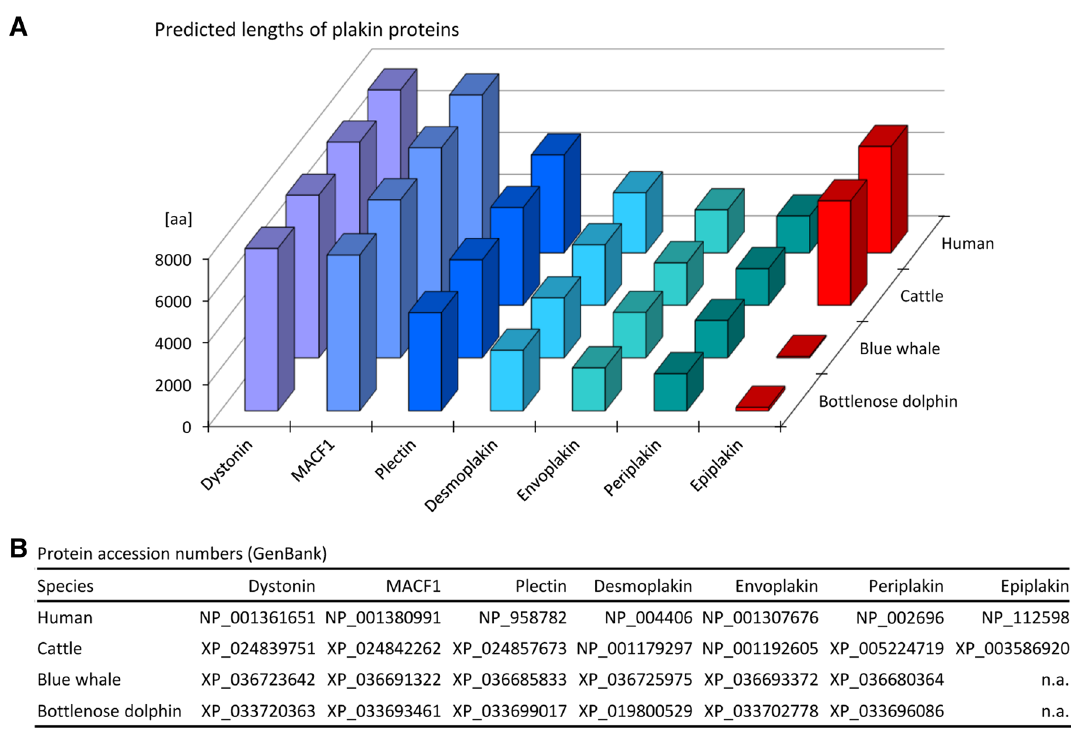
Figure 1. Size of plakin family proteins of land-dwelling mammals and cetaceans. ( A ) The predicted lengths of plakin family proteins are shown for human, cattle, blue whale and bottlenose dolphin. aa amino acid residues. ( B ) GenBank accession numbers of the proteins that were analyzed in panel ( A ). For EPPK1 of the blue whale and the bottlenose dolphin, no prediction was available in GenBank. These proteins were predicted in this study by translating the region from the conserved start codon to the first in-frame stop codon, as shown in Supplementary Table S1. n.a. not